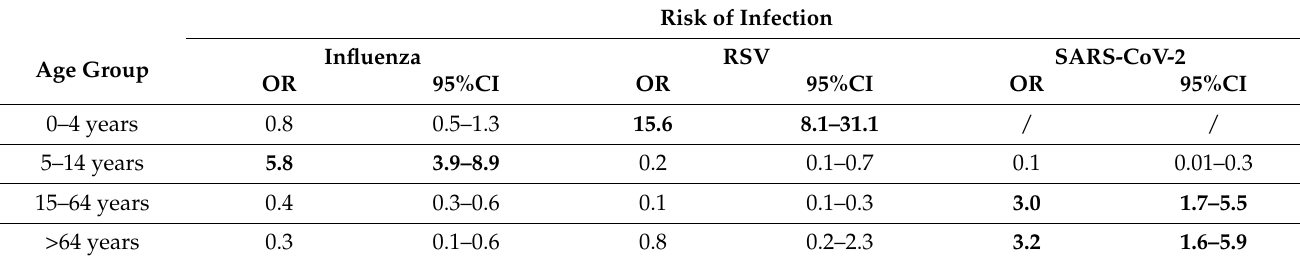
Risk of Infection